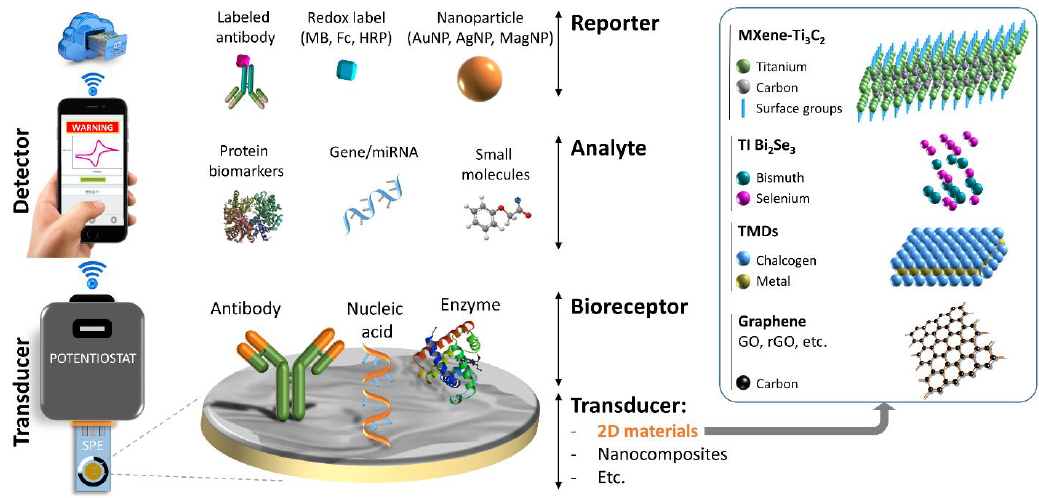
Figure 2. Schematic representation of an ideal electrochemical point-of-care (POC) screening device composed of a disposable screen printed electrode (SPE), a portable wireless potentiostat, a smart phone detector and further cloud storage. General configuration of di ff erent segments of electrochemical detection system is illustrated with the focus on four types of two-dimensional (2D) materials (graphene and its derivatives, transition metal dichalcogenides (TMDs), topological insulator (TI) Bi 2 Se 3 , and MXene-Ti 3 C 2